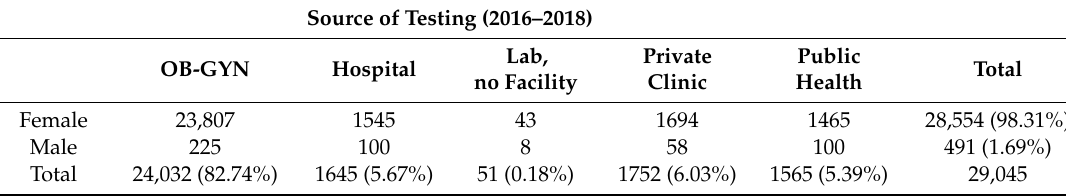
Table 2. Gender representation of Zika virus specimen testing by facility type from 2016 to 2018. Testing with OB-GYN clinics was identified as the most common facility type for testing both females and males. Males had the lowest testing count at private laboratories (without a facility) and private clinics. Males represented only 1.69% of the specimens